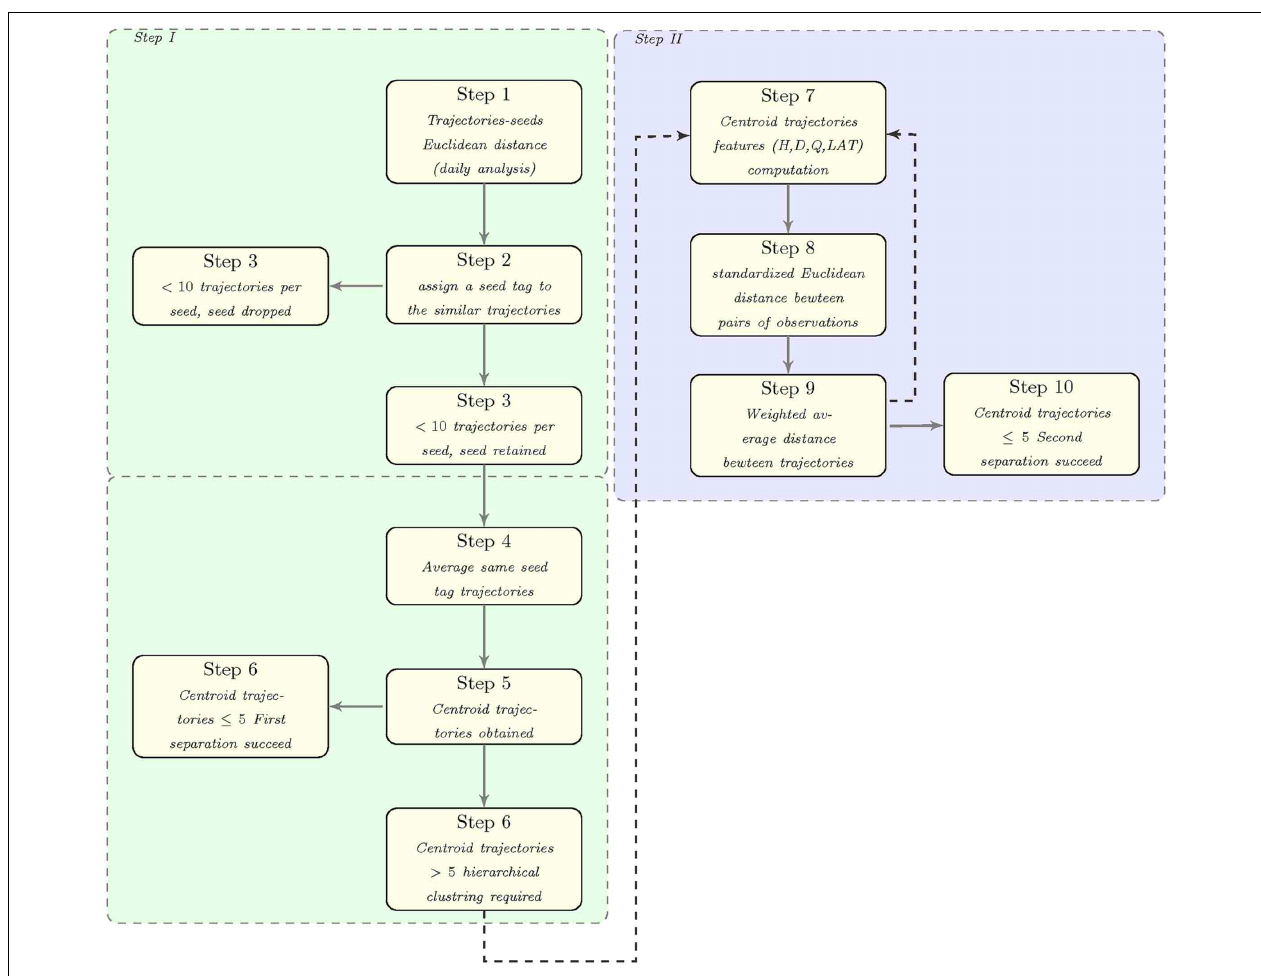
FIGURE 1 | Diagram summarizing the synoptic-scale circulation classification method based on Lagrangian Backward